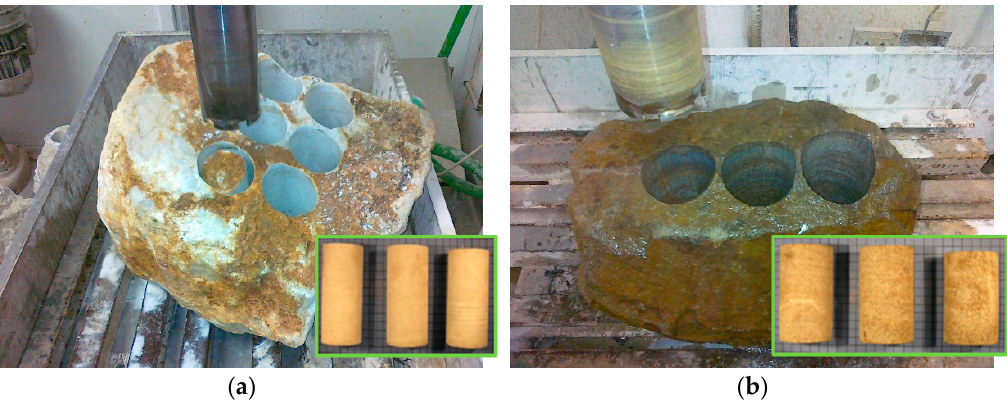
Figure 1. Core specimens of ( a ) marble and ( b ) metasandstone.